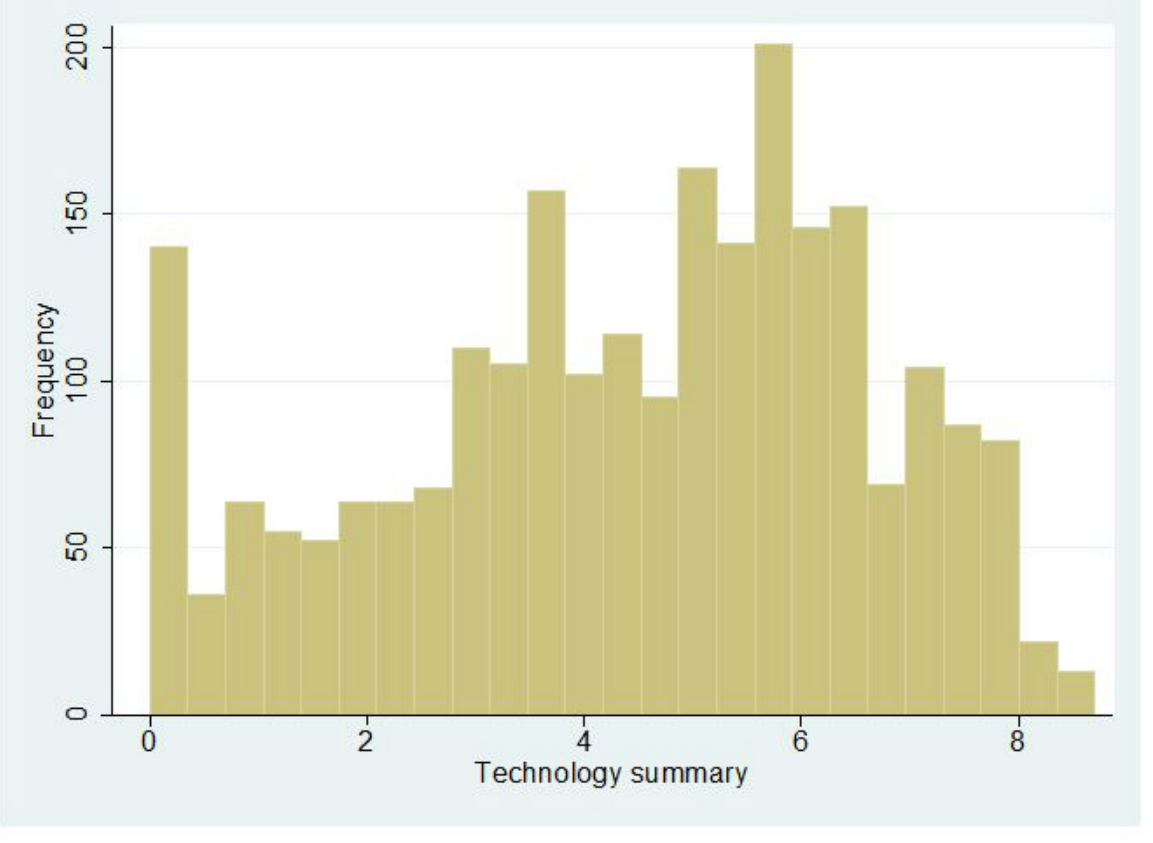
Figure 4. Distribution of scores: